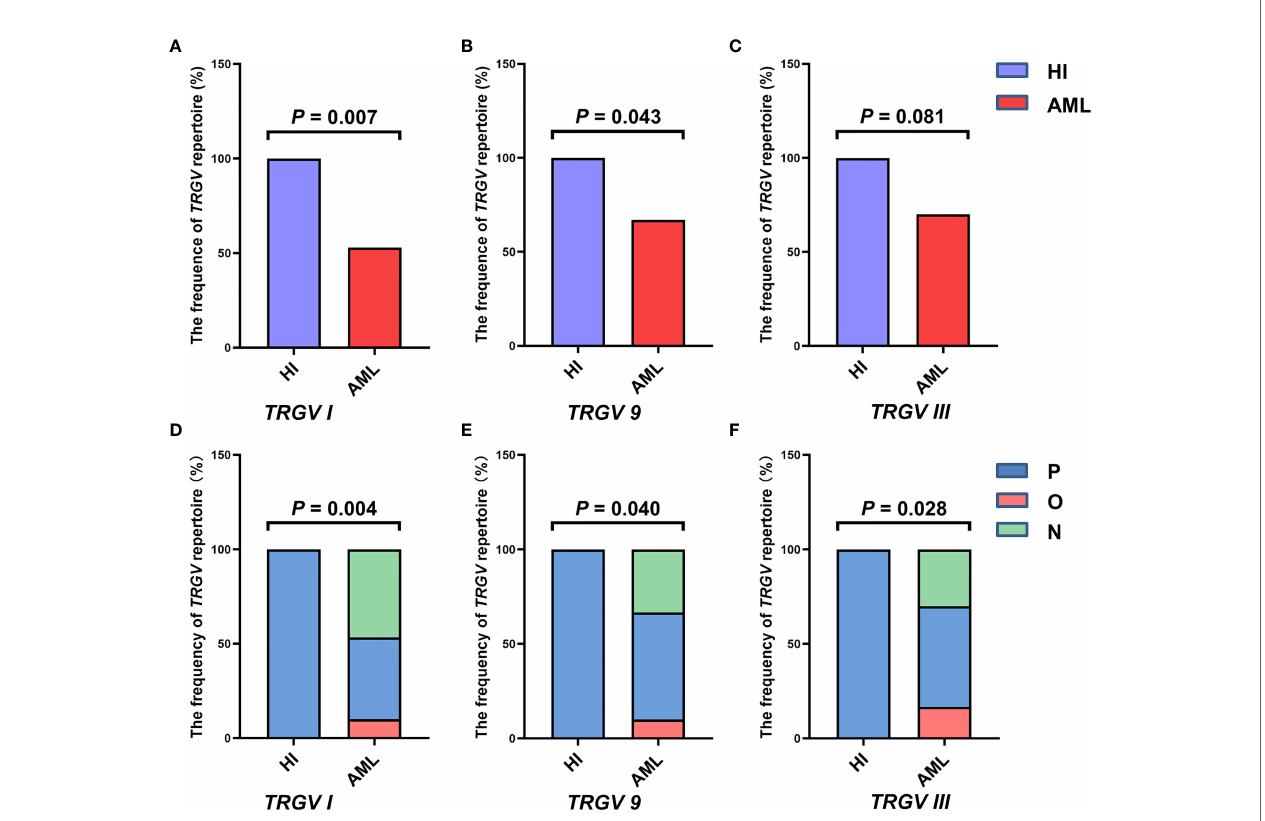
FIGURE 2 | Frequencies of the TRGV subfamilies in gd T cells from 10 healthy individuals and 30 patients with AML. The expression frequencies of three TRGV subfamilies in healthy individuals and patients with AML (using the Fisher ’ s exact test) (A – C) . The clonal expansion frequency of the three TRGV subfamilies in healthy individuals and patients with AML (using the Fisher ’ s exact test) (D – F) . P, polyclonality; O, oligoclonality; N,